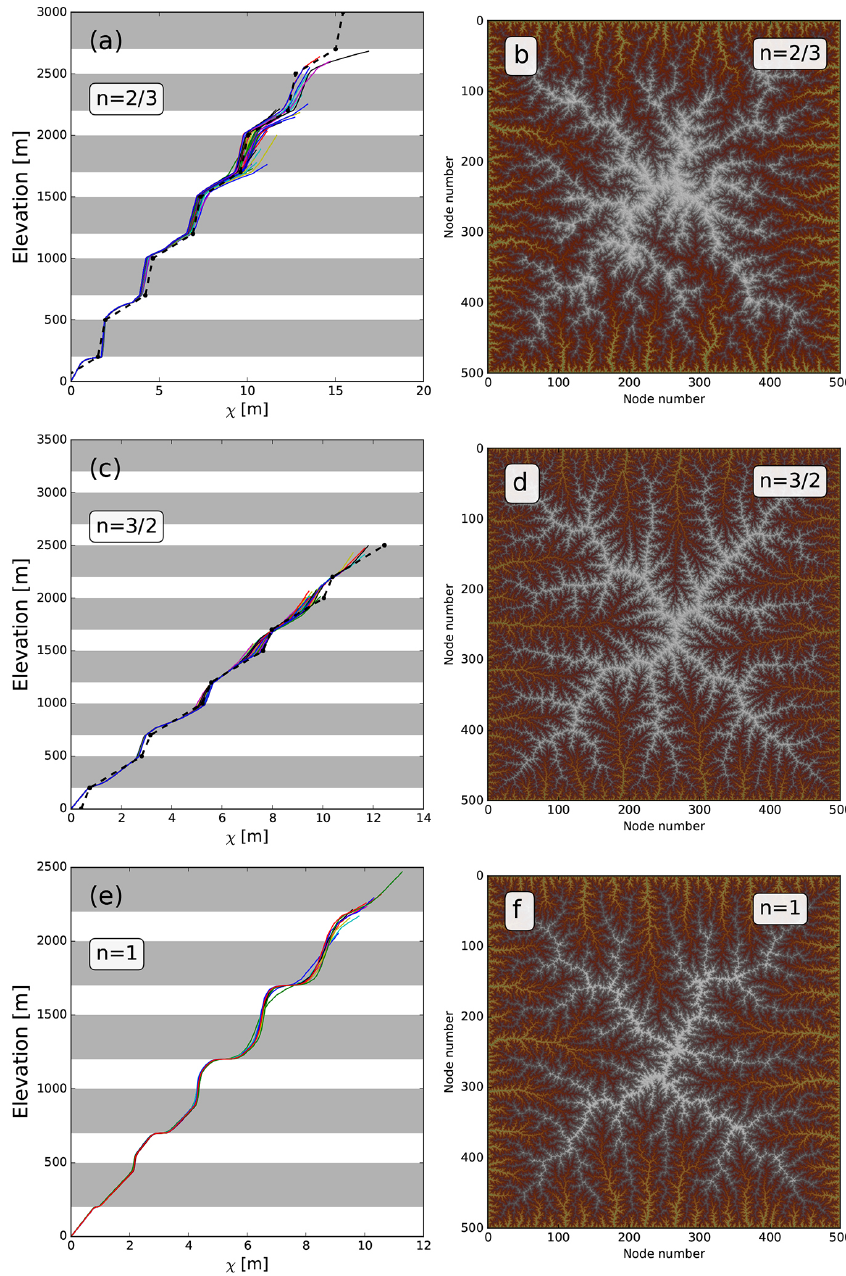
Figure 10. Results of the FastScape simulations. Lines in the left-hand panels are profiles extracted from the DEMs. Simulations were run at constant uplift with alternating bands of weak and strong rocks. Grey bands indicate the weaker rocks. The individual panels show simulations where n = 2 / 3 (a) , n = 3 / 2 (c) , and n = 1 (e) . The dashed lines (a, c) show the equilibrium profile predicted by the theory, with circles depicting predicted crossing points of the contacts. Profiles obtain similar shapes as in the 1-D simulations (Fig. 2b–d). Panels (b) , (d) , and (f) show DEMs of the landscapes formed in each simulation. Color represents elevation, with white being